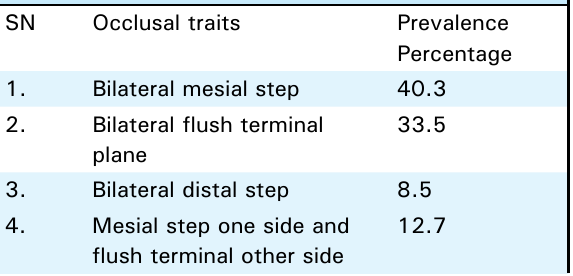
table 1. distribution of different types of occlusal